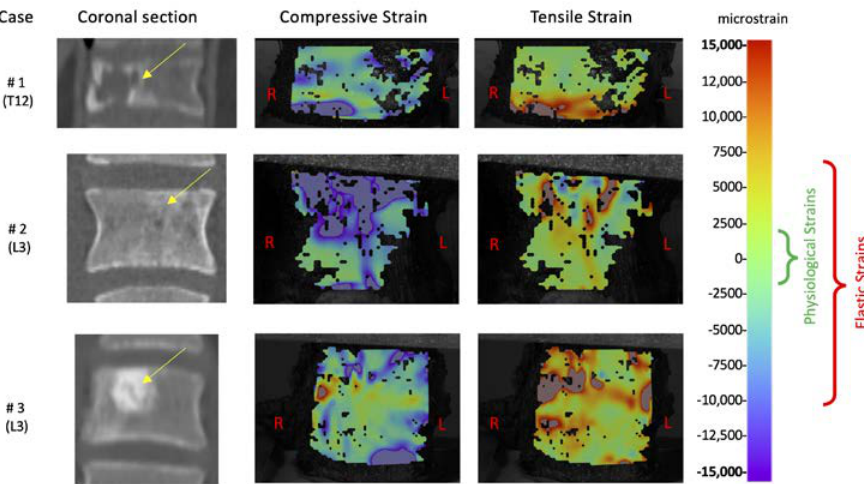
Figure 4. Compressive and tensile strains experimentally measured on the vertebral anterior surface. The coronal sections show the position of the tumor (arrows). The false color map represents in reddish color the tensile strain, and in bluish color the compressive strain. The green bracket indicates the physiological strain range, the red bracket indicates the elastic strain range for healthy cortical bone